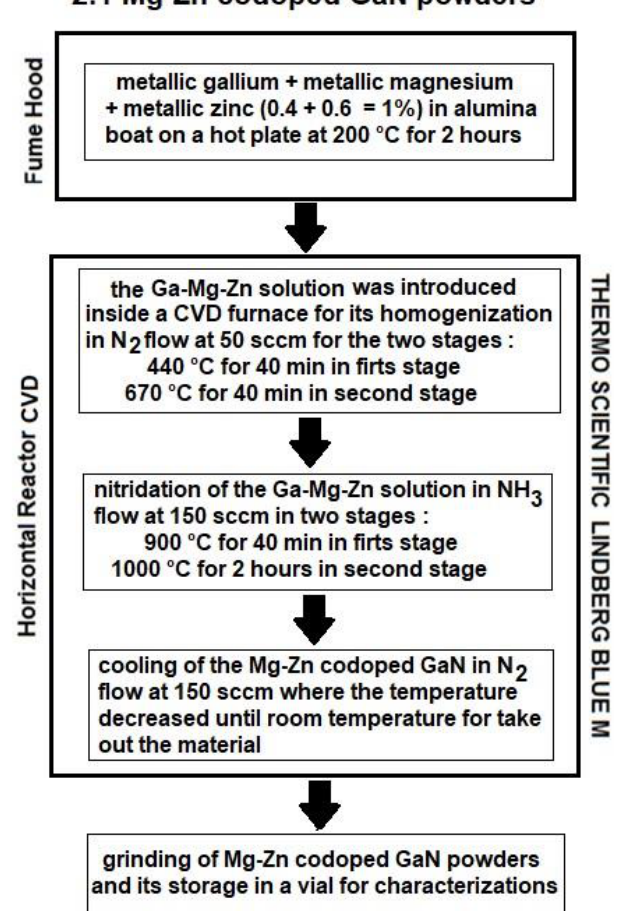
Figure 1. Diagram to obtain the Mg-Zn co-dopedGaN powders. Table 1. Parameters considered in the synthesis of Mg-Zn co-dopedGaN powders.